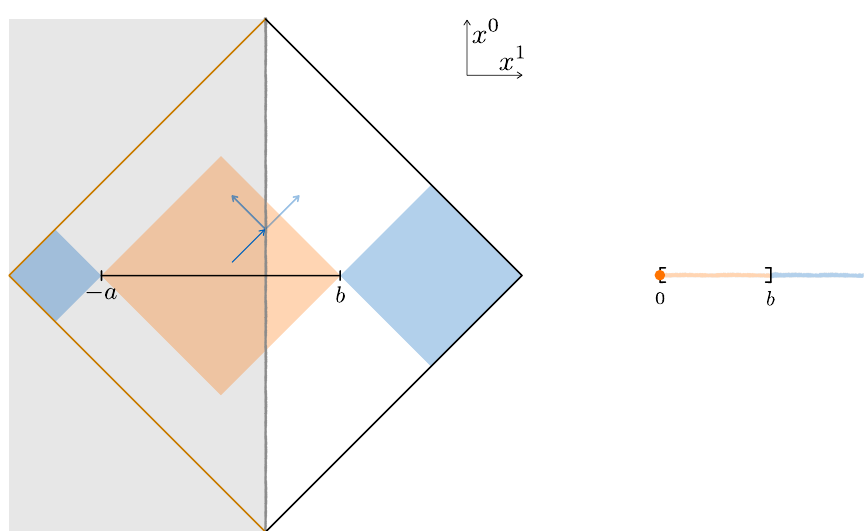
Figure 2: Left : Setup for the QES calculation for a partially reflecting AdS In the gray region gravity is dynamical and we will consider the Poincaré patch with its horizon drawn in orange. This region is glued along a the AdS flat space region on the right. The free fermion matter lives in both the AdS flat space regions, but there is partial reflection at the interface, with transmission coefficient t (and reflection coefficient r “ 1 ´ t ). This is a toy model to capture the graybody effects in the black hole atmosphere. A candidate entanglement wedge r´ a , b s is shaded orange and its complement in shaded blue. Right : The dual SYK + wire system. The fundamental computation we are doing is of the entropy and the entanglement wedge of the interval r 0 , b s in this non-gravitational